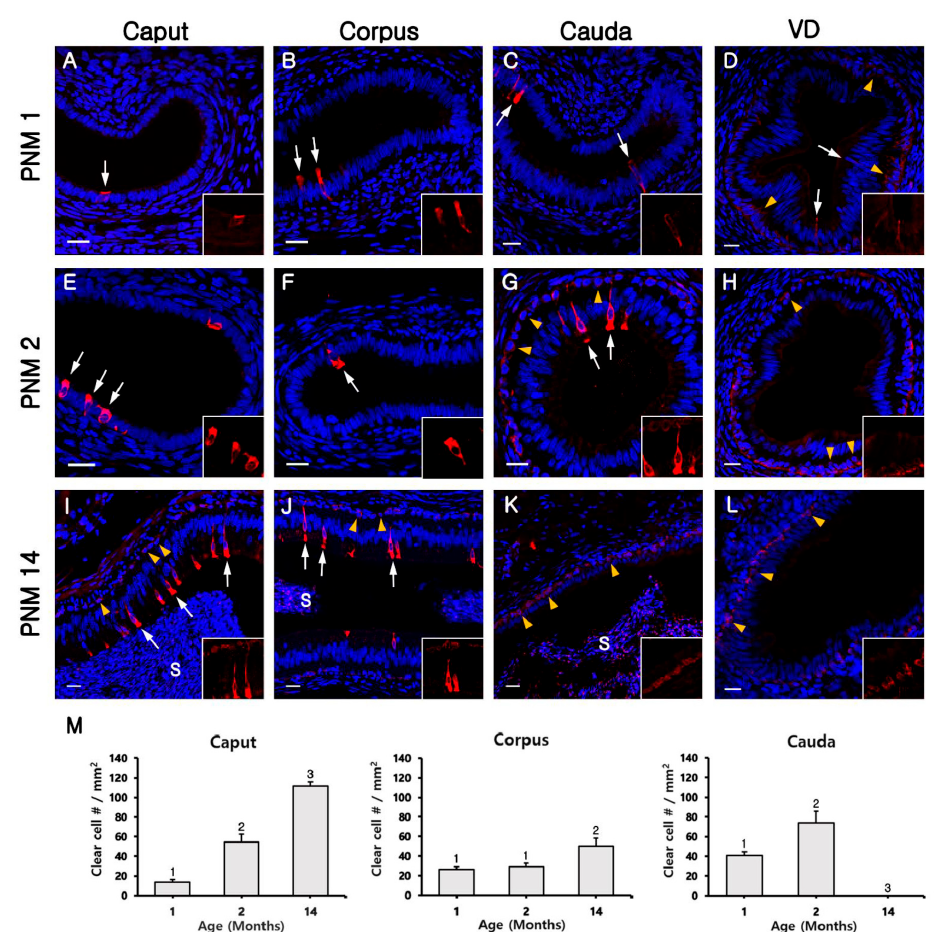
Figure 2. Progressive appearance of CCs from the vas deferens (VD) to the caput of the goat epididymis. Clear cells in the epididymis were labeled for B1-VATPase (red). ( A–D ) The epididymis at postnatal month (PNM) 1. ( E–H ) The epididymis at PNM2. ( I–L ) The epididymis at PNM14. The arrows and arrowheads indicate positive epithelial cells in the inner and outer epithelium, respectively. S, spermatozoa. The nuclei were labeled with DAPI (blue). Bars = 20 µm. ( M ) Changes in the proportion of CCs in the caput, corpus, and cauda. The cell were calculated based on the number of CCs in the epithelium per square millimeter of the epididymis area. The results are expressed as the mean ± standard error of the mean. Different letters indicate significant differences ( p < 0.05).